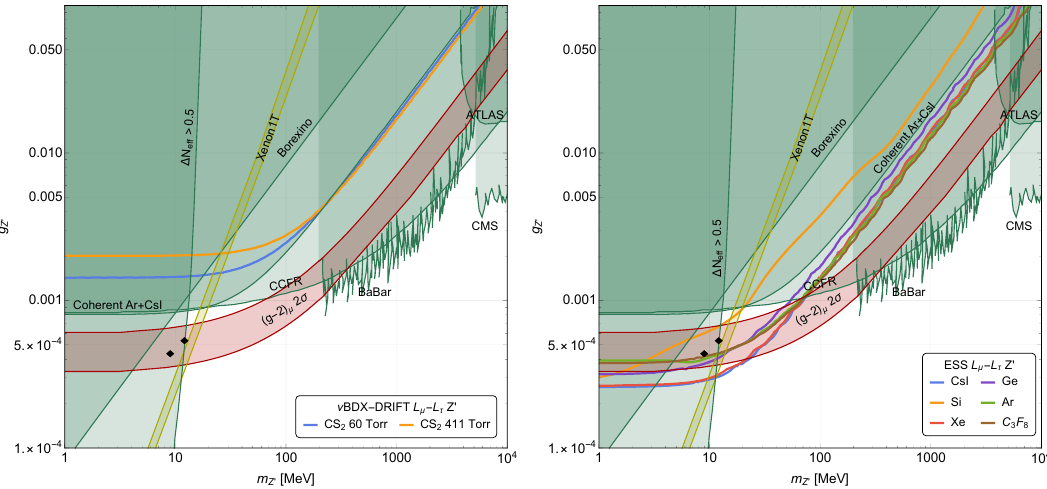
Figure 5. Future sensitivity at 90 % C.L. in the m Z 0 − g Z 0 plane for the L µ − L τ model for the ν BDX-DRIFT detector (left) exploiting CS 2 at two different pressures, and the various detectors described in the text at the ESS (right). The dark green shaded areas are excluded at 95% C.L. by BaBar [56], ATLAS [57, 58], CMS [59], CCFR [60, 61], at 90% C.L. by Borexino [62, 63] assuming that the Z 0 decays to muons, and disfavoured by ∆ N eff [64]. In the red region the model explains at 2 σ the anomalous magnetic moment of the muon [65–70]. The yellow band shows the region that can explain the Xenon1T excess [71] in some specifically extended L µ − L τ model [72], while the black diamonds refer to a model [73] that explain the cosmic neutrino spectrum features observed by IceCube